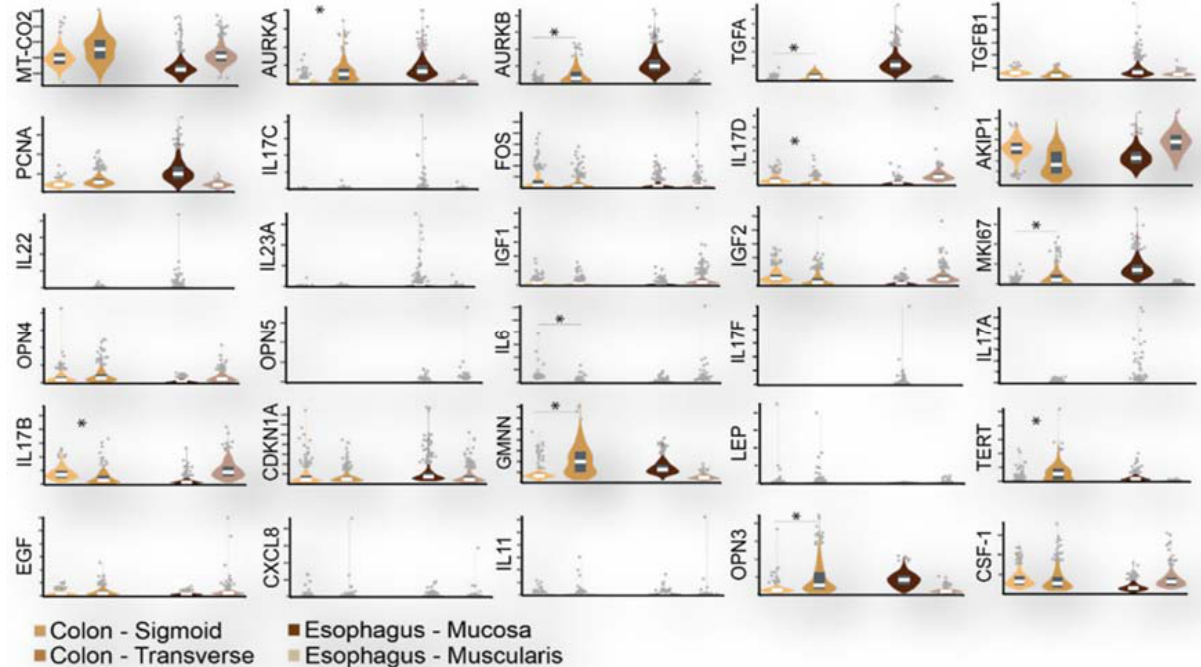
Figure 3. Mitosis and regenerative inflammation genes can serve as biomarkers of risk because they vary among individuals and intestinal site. Violin plots depict a wide inter-individual distribution in expression of 30 mitosis and regenerative inflammation genes in the human colon (sigmoid muscularis and transverse muscularis and mucosa) and oesophagus (mucosa and muscularis). * denote >2 or <0.5 gene expression fold change between sigmoid muscularis ( n = 318) and transverse muscularis and mucosa ( n = 368) calculated in Transcripts Per Million from RNA-Seq data retrieved from GTEx Analysis Release V8 (dbGaP Accession phs000424.v8.p2; https://www.gtexportal.org/ home/datasets (accessed on 4 May